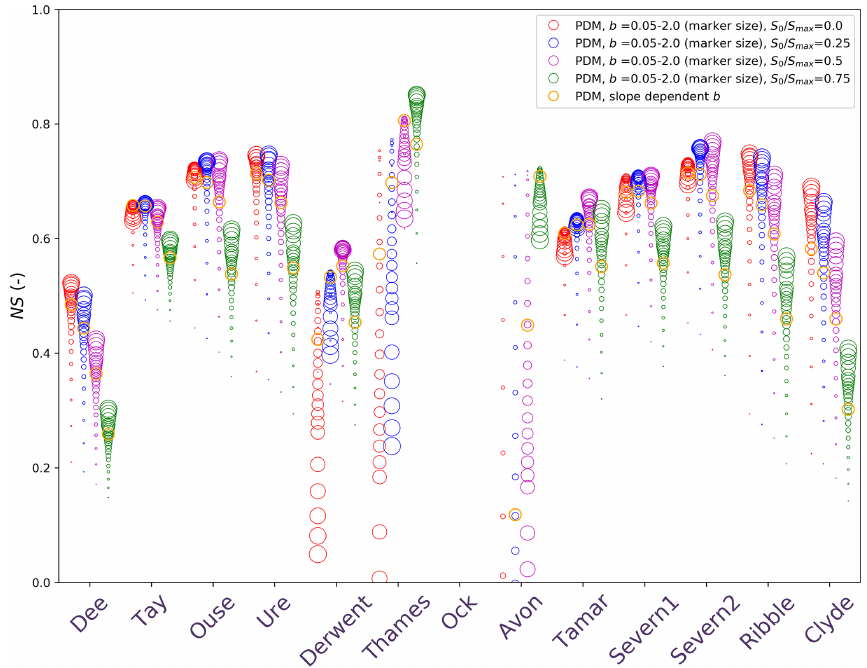
Figure 5. River flow NS efficiency performance metric for the PDM catchment tests detailed in Sect. 2.2.2. The x axis represents the 13 selected catchments (Fig. 1). The marker colour represents the S 0 /S max value (red, blue, purple and green for values of 0.0, 0.25, 0.50 and 0.75, respectively) and the marker size represents the b parameter (larger circles for larger b values). The slope-dependent b tests are represented by orange markers. Only results from those tests using the VG approach for soil formulation are shown. Tests at the Ock catchment are not visible since they obtained negative